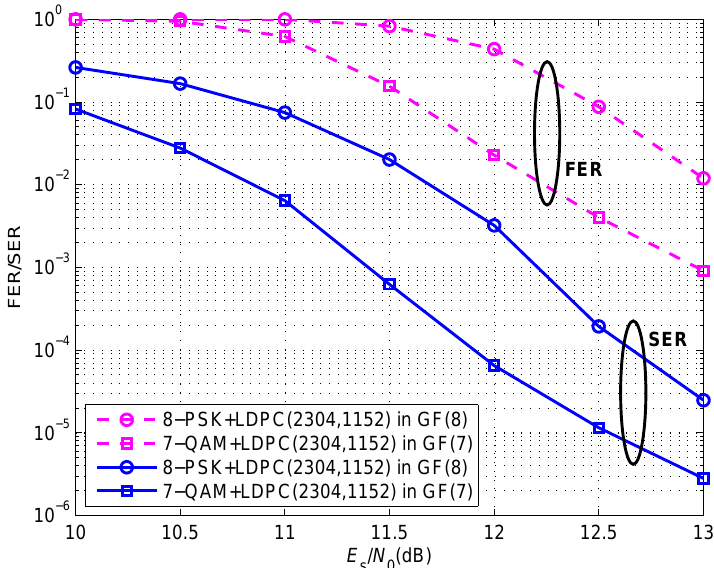
Figure 8. FER and SER of different modulations combined with NB-LDPC codes over the non-linear satellite